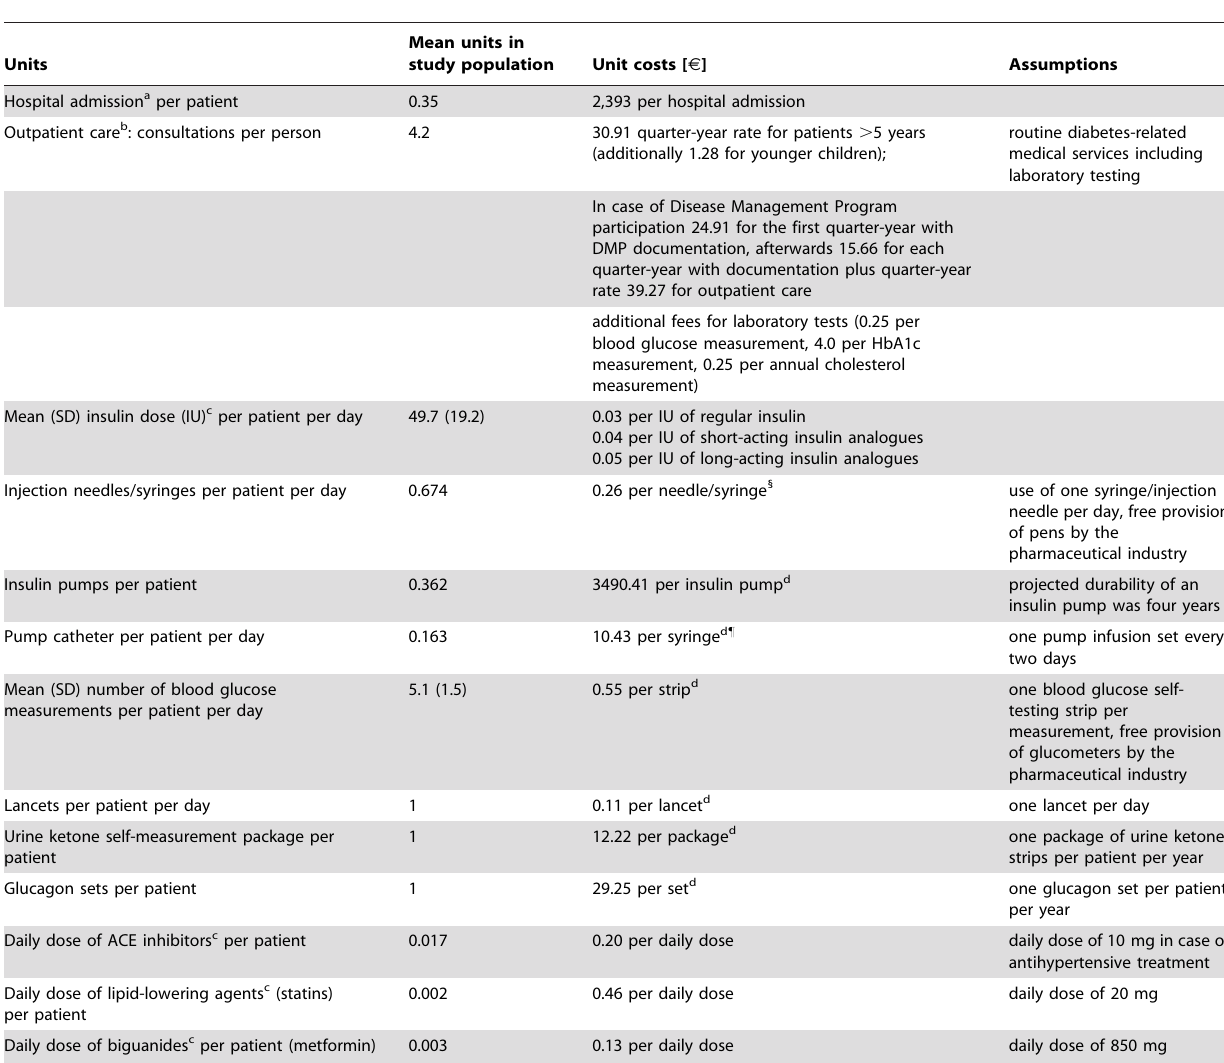
Table 1. Health care utilization included in cost analysis, and unit costs [ J ,